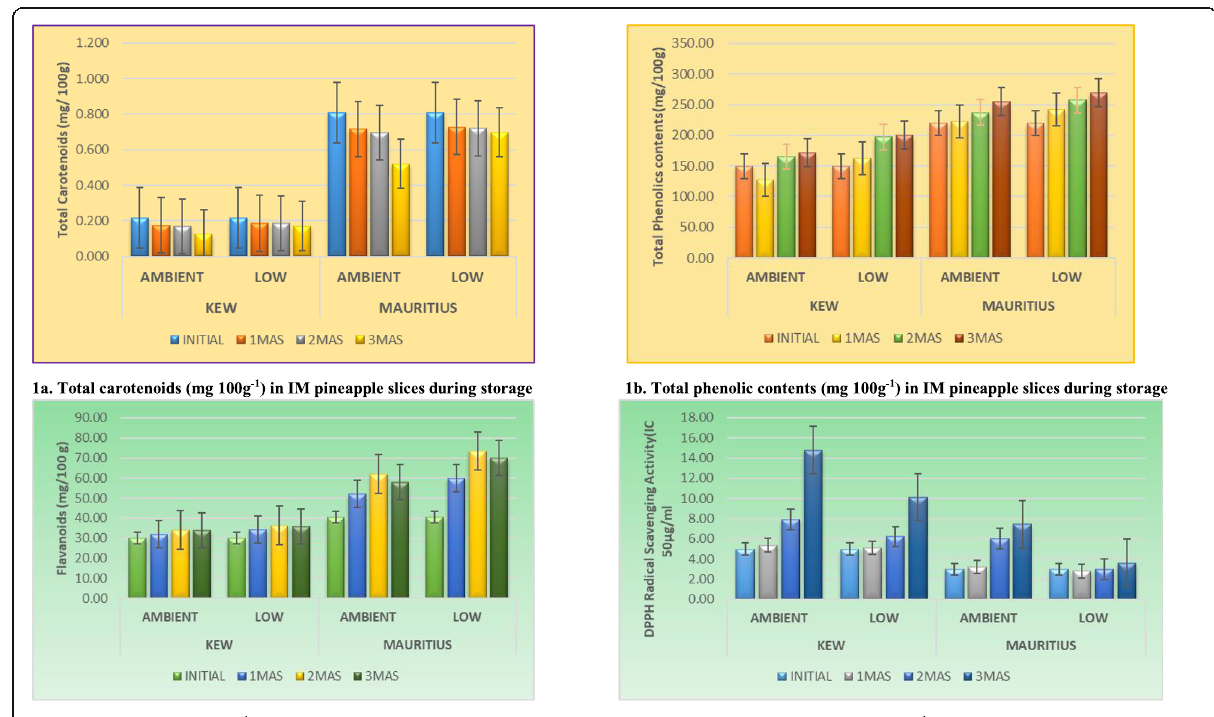
Fig. 1 a Total carotenoids (mg 100 g − 1 ) in IM pineapple slices during storage. b Total phenolic contents (mg 100 g − 1 ) in IM pineapple slices during storage. c Total flavonoids (mg 100 g − 1 ) in IM pineapple slices during storage. d DPPH radical scavenging activity (IC 50 μ l ml − 1 ) of IM pineapple slices during